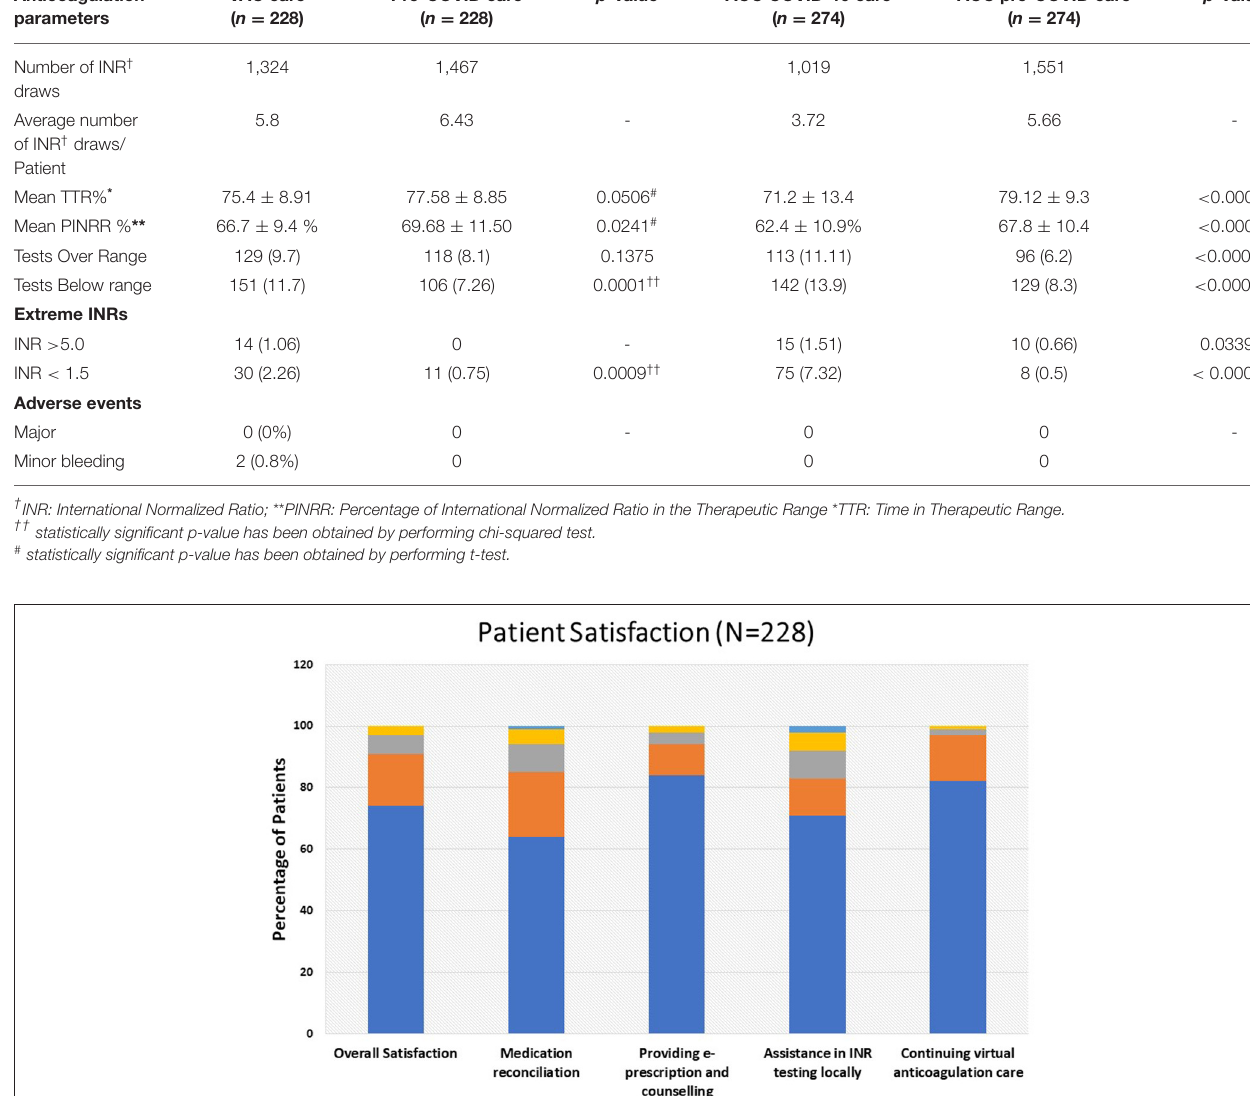
TABLE 3 | Assessment of Anticoagulation parameters among Pre-VAC (pre COVID) and VAC care. Anticoagulation parameters